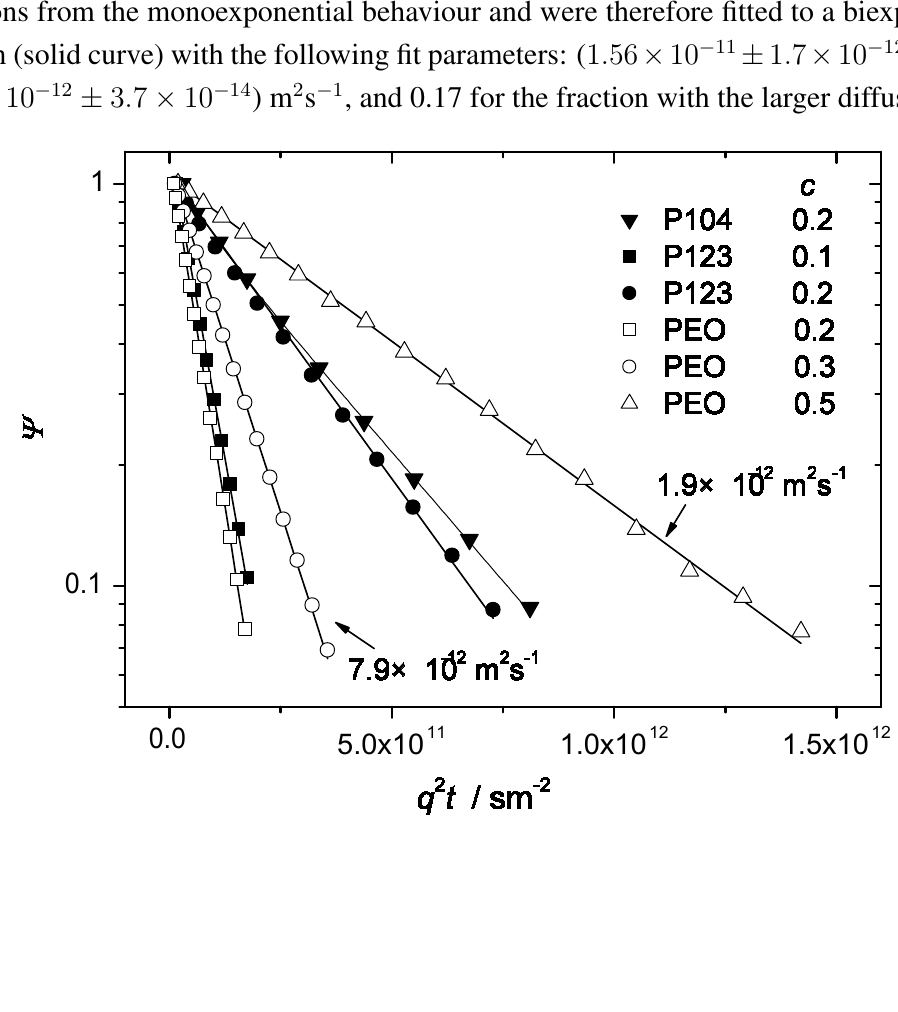
Figure 2. The normalized spin echo diffusion attenuations of polymer molecules in the samples P123, P104 and PEO in water at T = 23 ◦ C. The polymer concentrations are indicated on the plot. For the Pluronic samples these concentrations are in the range of the micellar state. All experimental data sets except for that of P104 ( c = 0 . 2 ) were satisfactorily fitted by mono-exponential function as shown by solid lines. The fitted values of diffusivities are indicated for two slopes as an example. The data points for P104 ( c = 0 . 2 ) showed deviations from the monoexponential behaviour and were therefore fitted to a biexponential function (solid curve) with the following fit parameters: ( 1 . 56 × 10 − 11 ± 1 . 7 × 10 − 12 ) m 2 s − 1